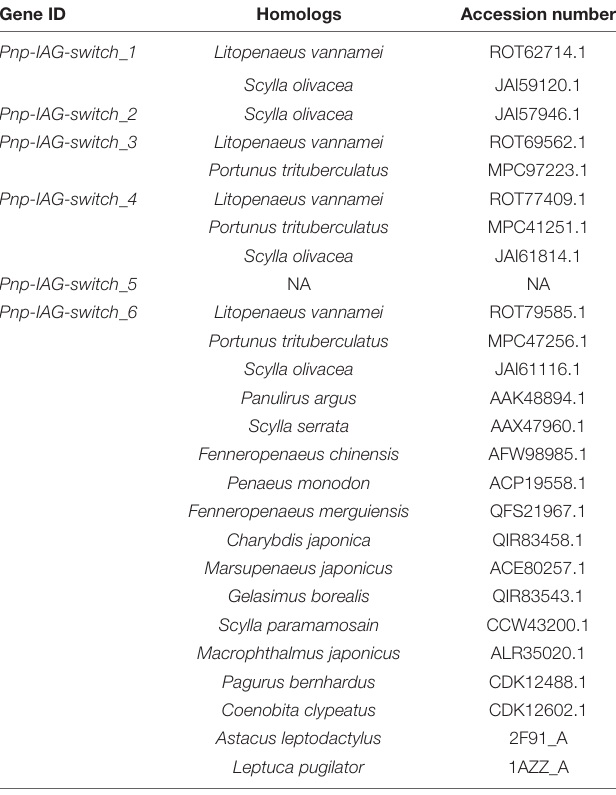
TABLE 2 | Homolog sequences of the genes from Table 1 in other decapod